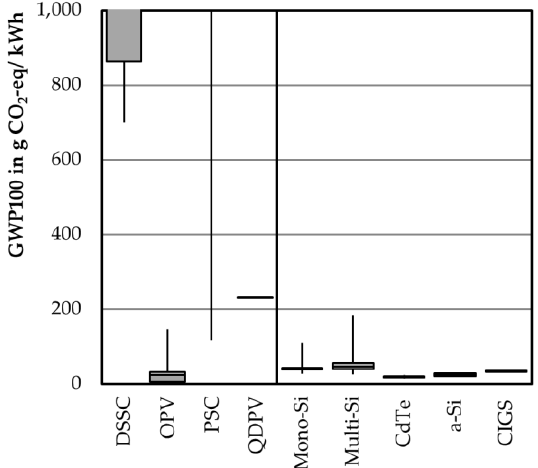
Figure 4. Global warming potential (GWP) status quo of current development of emerging PVs as presented in the LCA datasets and harmonized to the key performance parameters (KEYPs) in Table 3 and current maximum reported lifetimes of one and seven years. The comparison was based on benchmarks of the first- and second-generation PVs based on the standard values of the KEYPs (I H = 1700 kWh / (m 2 · year); PR H = 80%; τ H = 30 years;